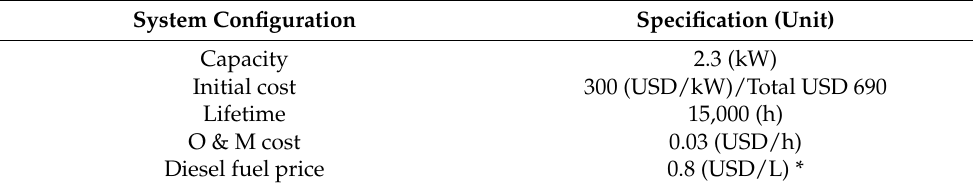
Table 7. Specifications of the applied diesel generator.